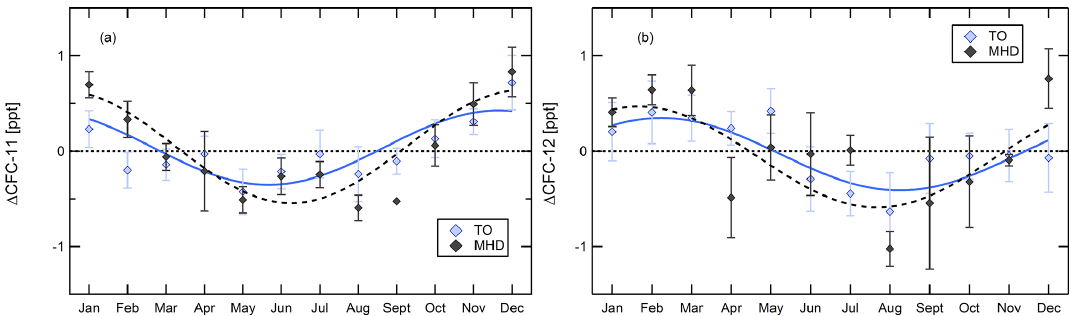
Figure 5. Seasonality of CFC-11 (a) and CFC-12 (b) at Taunus Observatory (coloured symbols, baseline data only) and Mace Head (black symbols). Plotted are monthly mean values as difference to the mean of the total detrended